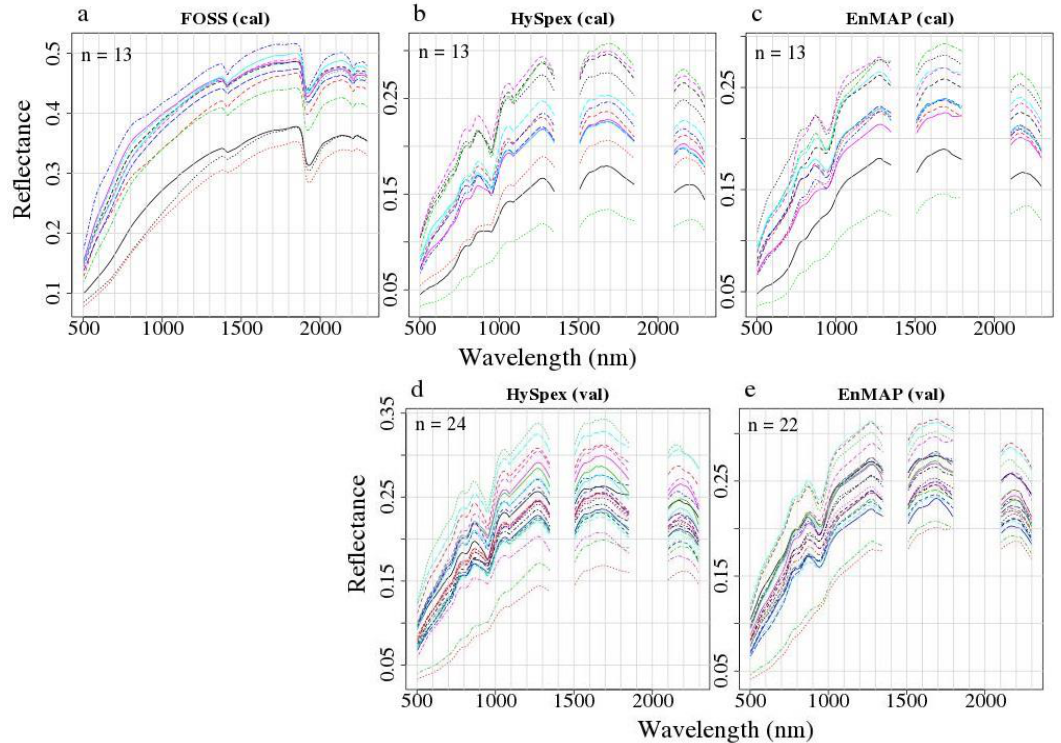
Figure 5. Reflectance spectra of laboratory spectrometer FOSS (left; a ), airborne HySpex (middle; b , d ) and simulated satellite EnMAP (right; c , e ) of the calibration samples (top; a – c ) and validation samples (bottom; d , e ). FOSS laboratory spectra were used for laboratory modelling while HySpex / EnMAP spectra were used for the remote sensing model. n is the number of soil samples.